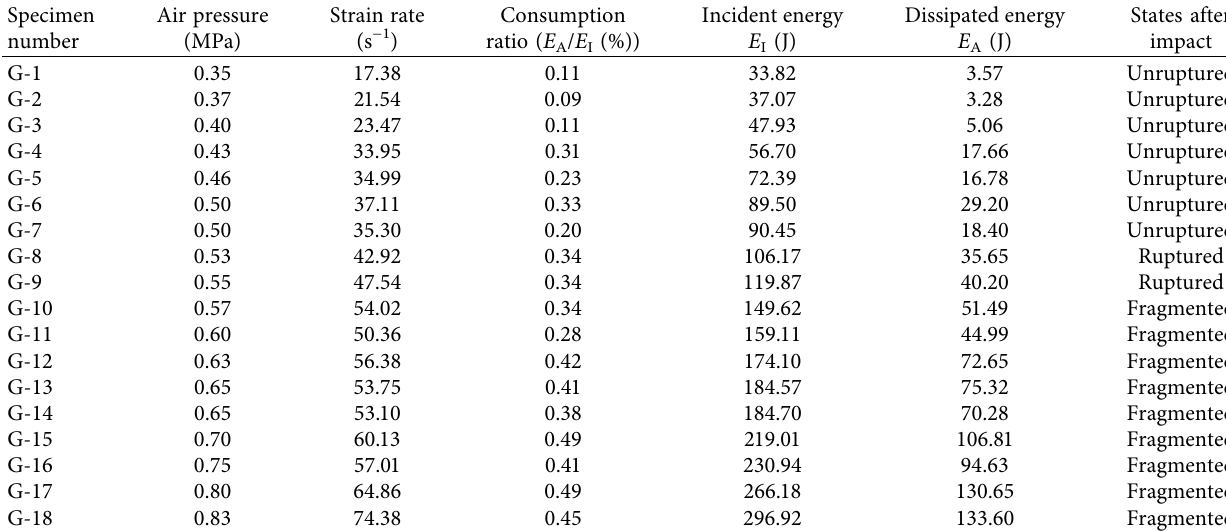
Figure 8: Strain rate versus incident energy. (a) Dissipated energy (b) and energy consumption ratio Table 2: Incident energy, dissipated energy, and energy consumption ratio based on measurement.